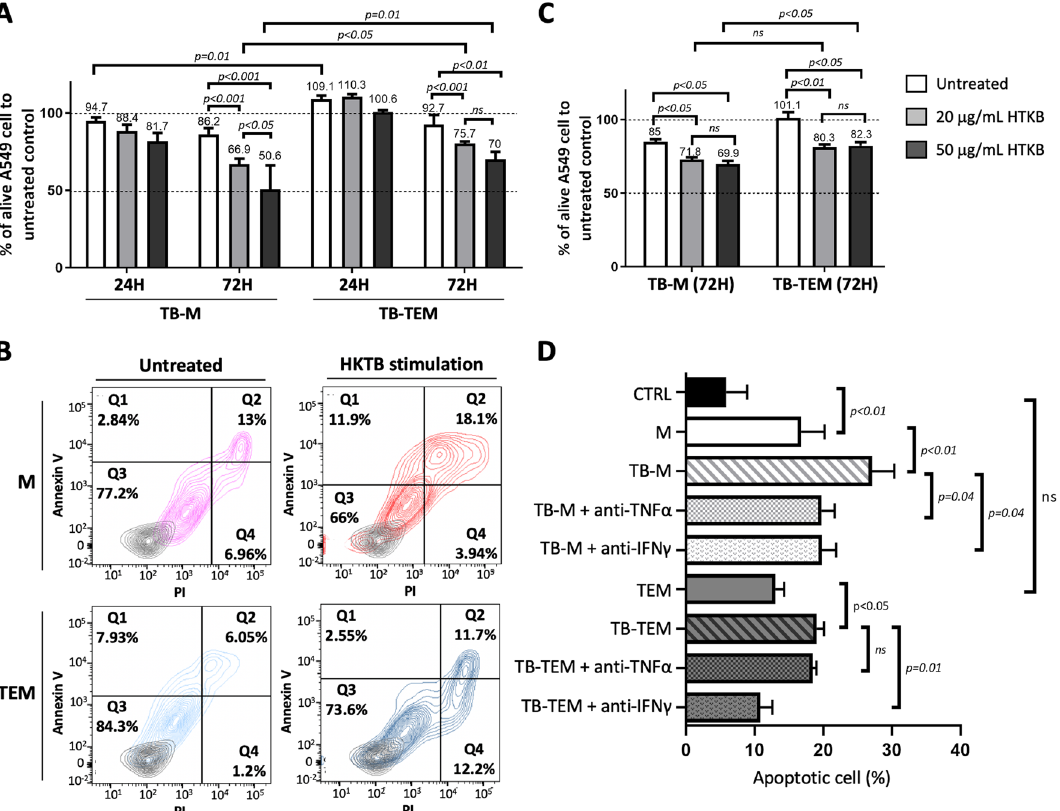
Figure 5. Cytotoxicity analysis of heat-killed tuberculosis (HKTB)-stimulated classically activated macrophages (Ms) and tumor-educated macrophages (TEMs) against A549 cells. ( A ) An MTT assay was used to determine A549 cell viability upon coculture with Ms and TEMs as well as HKTB-stimulated Ms (TB-M) and TEMs (TB-TEM) stimulated with 20 or 50 mg/mL HKTB for 24 or 72 h, respectively. ( B ) Flow cytometric analysis of A549 cells showed apoptotic and necrotic cells within the cell population. ( C ) The MTT assay determined A549 cell viability upon culturing with medium from Ms and TEMs and from TB-M and TB-TEM stimulated with 20 or 50 mg/mL HKTB for 72 h. ( D ) The flow cytometric assay determined A549 cell viability with or without the inhibition of tumor necrosis factor (TNF)-α and INF-γ. ns, not